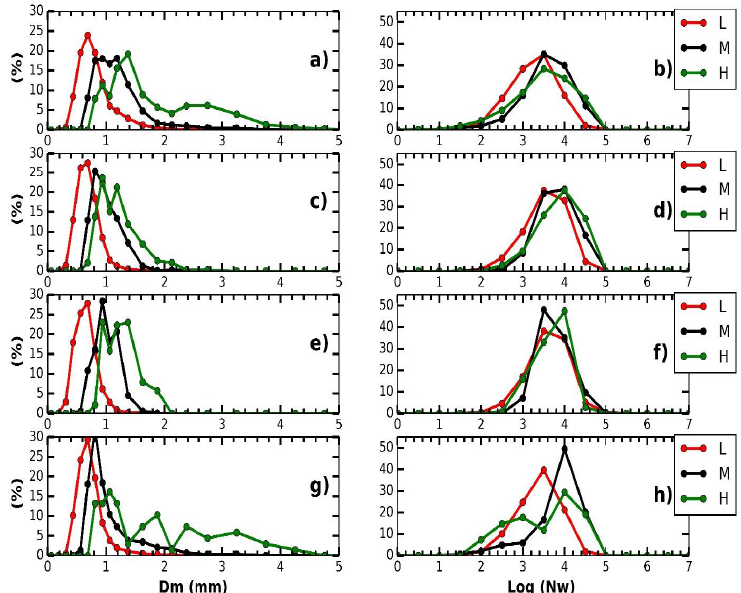
Figure 5. Distribution functions of the normalized Gamma function parameters of RSD for different times of day. Left column: Dm (mm). Right column: Nw. ( a ) and ( b ); 15–20 LST; ( c ) and ( d ): 21–02 LST; ( e ) and ( f ): 03–08 LST and ( g ) and ( h ): 09–14 LST. Table 3. Date and time of occurrence of the rainfall events containing at least 10 min of convective rainfall in a sample of 18 months, between 2017 and 2019 with Parsivel2 records. S is the time (minutes) duration of the stratiform rainfall in every event and C is the time (minutes) duration of the convective rainfall in every event. 𝐷𝑚 𝑚𝑎𝑥 is the maximum diameter (mm) and 𝑅 𝑚𝑎𝑥 is the maximum rain rate (mm/h) of the rainfall event.